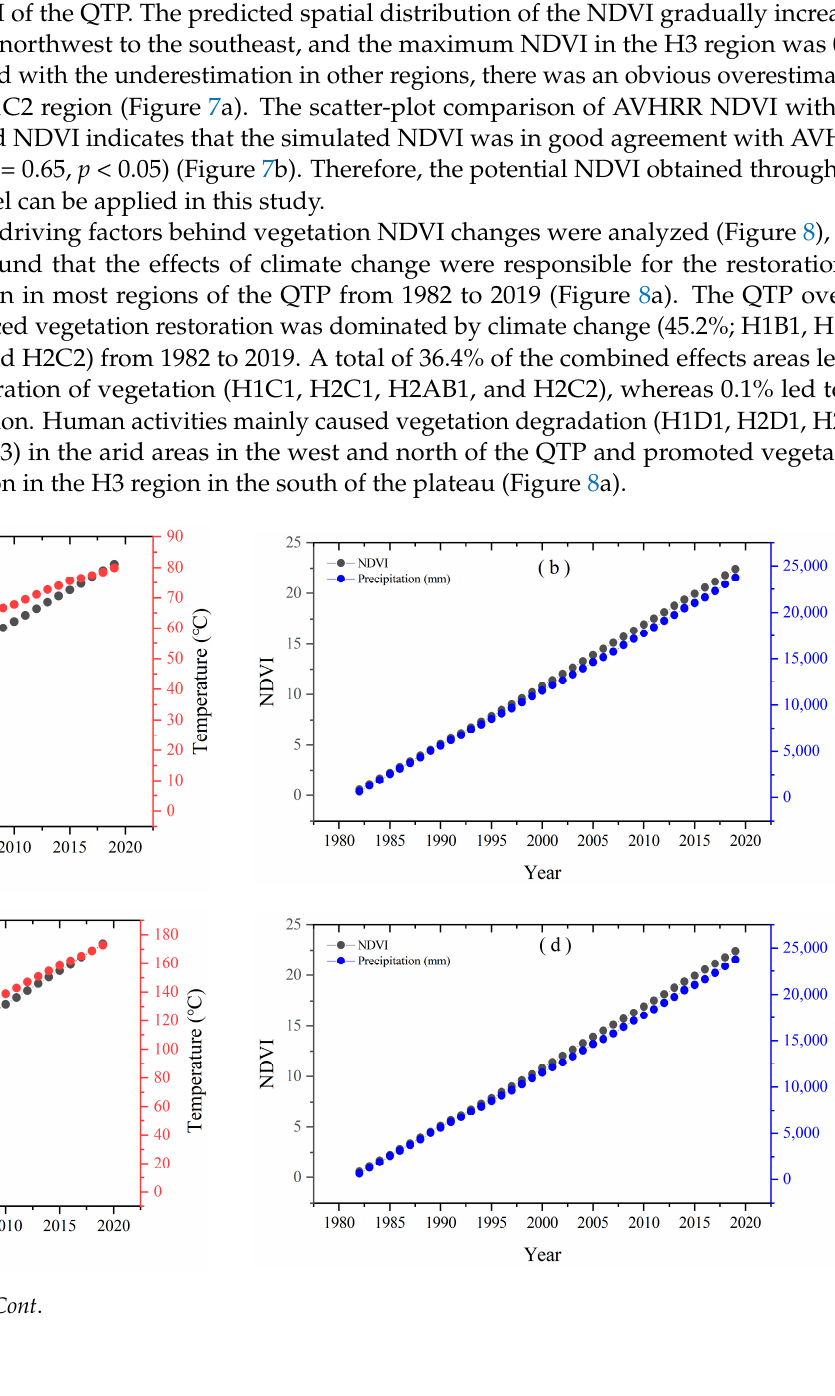
Figure 5. Spatial patterns of the Pearson correlations between AVHRR NDVI and temperature ( a ) and precipitation ( b ) on the QTP from 1982 to 2019.